Question: What does this figure show? Answer in one sentence.
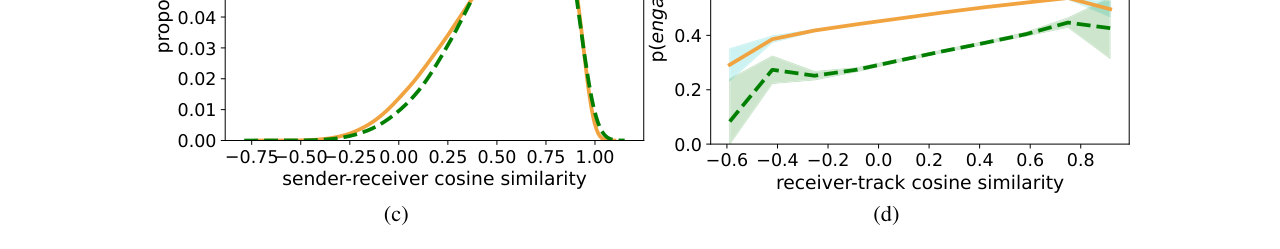
Answer: Effects of reciprocity (a-b) and share media type (c-d) on the probability of becoming engaged with the artist: (a) Distribution of sender-receiver cosine similarities in our sample, separated by reciprocal and non-reciprocal tie. (b) Probability of engagement following link share as a function of receiver-track cosine similarity, separated by reciprocal and non-reciprocal tie. (c) Distribution of sender-receiver cosine similarities in our sample, separated by direct or broadcast application. (d) Prob- ability of engagement following link share as a function of receiver-track cosine similarity, separated by direct or broadcast application.